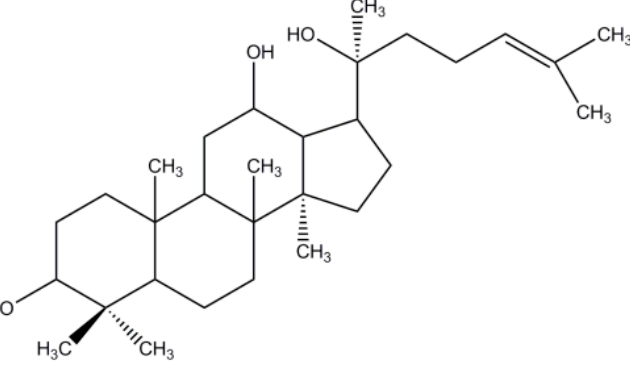
Figure 1. Chemical structure of 20( S )-protopanaxadiol (PPD).